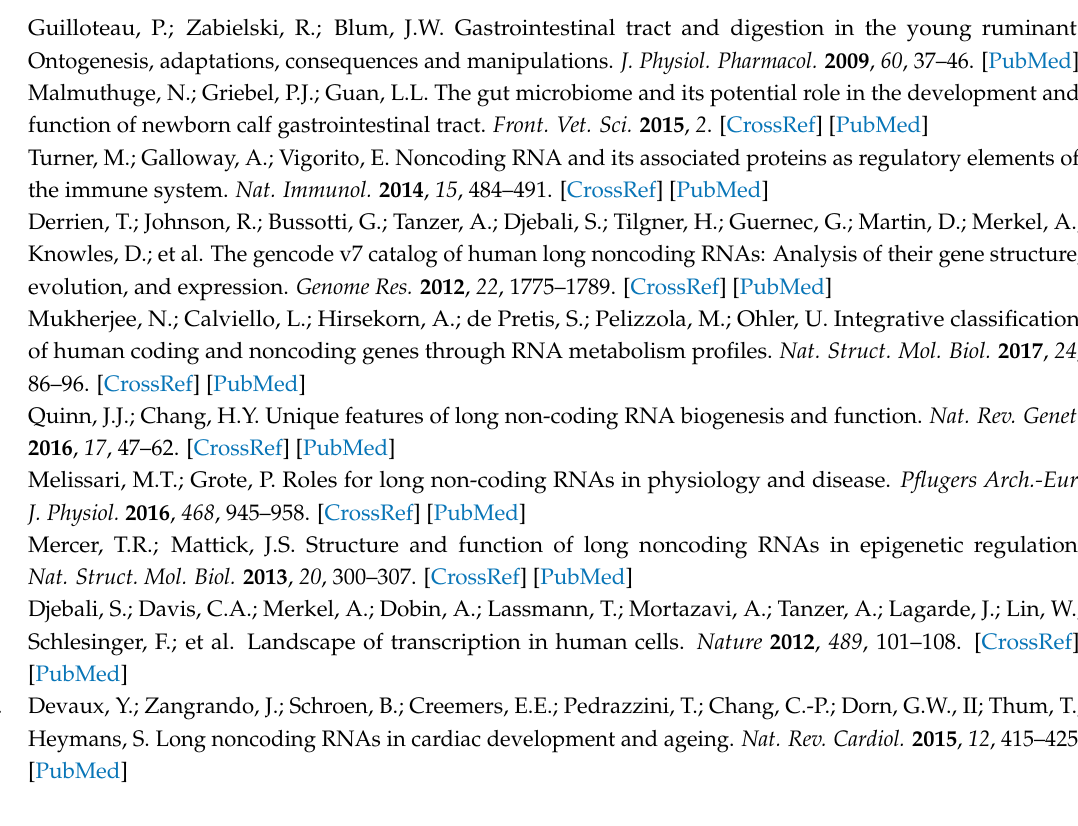
Figure S1: KEGG pathways enriched for differentially expressed mRNAs in rumen tissue, Figure S2: KEGG pathways enriched for differentially expressed mRNAs in ileum tissue, Table S1: Genes and primer sequences used in qPCR validation of RNA-Sequencing data, Table S2: RNA-Seq read mapping statistics, Table S3: Genes (mRNA) in (a) rumen and (b) ileum tissues retained for further analyses, Table S4: Identified lncRNA genes in ileum and rumen tissues of calves. (a) Ileum known lncRNAs; (b) Ileum novel lncRNAs; (c) Rumen known lncRNAs; (d) Rumen novel lncRNAs; (e) LncRNAs common to ileum and rumen tissues, Table S5: Genomic features and characteristics of identified lncRNA. (a) Transcript length distribution of lncRNAs; (b) Chromosomal distribution of identified lncRNA genes and transcripts in ileum and rumen tissues of calves; (c) Number of transcripts per lncRNA gene and exons per lncRNA transcript; and (d) LncRNA classes based on genomic location, Table S6: Differentially expressed mRNAs in (a) ileum and (b) rumen tissues and (c) common DE mRNAs, Table S7: (a) GO terms enriched for rumen DE mRNAs; (b) KEGG pathways enriched for rumen DE mRNAs; (c) GO terms enriched for ileum DE mRNAs; (d) KEGG pathways enriched for ileum DE mRNAs, Table S8: Potential cis target genes of lncRNAs in (a) rumen and (b) ileum tissues and (c) differentially expressed lncRNAs and their differentially expressed mRNAs, Table S9: (a) GO terms enriched for rumen lncRNA potential cis target genes; (b) KEGG pathways enriched for rumen lncRNA potential cis target genes; (c) GO terms enriched for ileum Table S10: Differentially expressed lncRNAs between day 33 and day 96 in rumen (a) and ileum (b) and potential cis target mRNAs for DE lncRNAs in (c) rumen and (d) ileum tissues. Availability of Sequence Data: The sequence data has been submitted to Gene Expression Omnibus database (BioProject PRJNA400067) and it is available through this link: